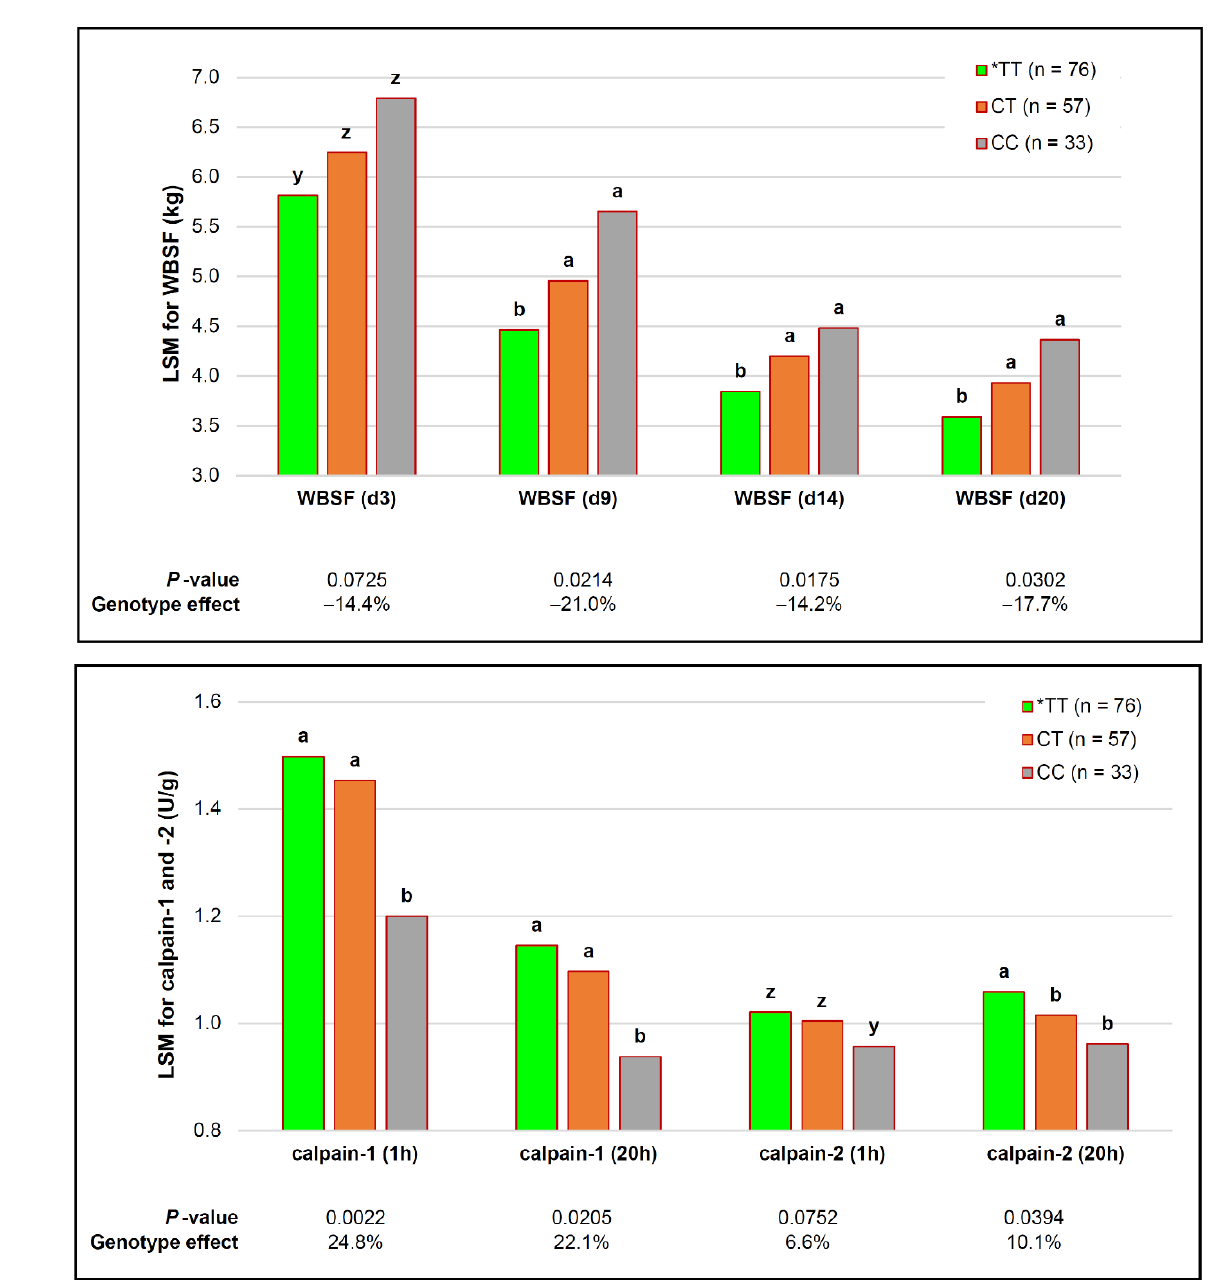
Figure 4. Additive effects of the capn1_187 genotype and ageing on tenderness in representative purebred South African beef bulls. *TT—the genotype that favored tenderness. Within each ageing period, different ascending letter superscripts (a, b) were significantly different p ≤ 0.05), and those that tended to be significantly different p ≤ 0.10) were indicated with different descending letter superscripts (z, y): ( a ) Warner–Bratzler shear force (WBSF); the effect on d 20 only tended to be significant after FDR adjustment (adjusted p ≤ 0.0558); ( b ) calpain protease activities.